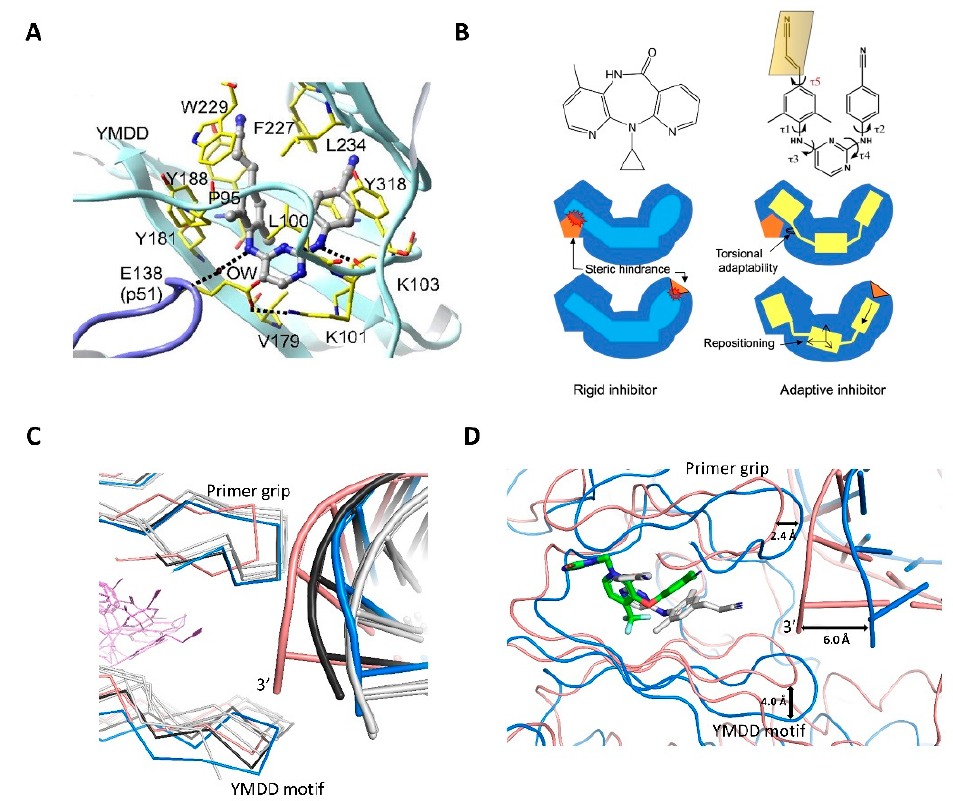
Figure 5. NNRTI binding and its impacts on RT and nucleic acid substrates. ( A ) Binding of RPV (gray stick) to the NNRTI-binding pocket (NNIBP) (PDB ID = 2ZD1); key residues in NNIBP are highlighted in yellow; the figure is reprinted from Reference [103]; copyright (2008) National Academy of Sciences. ( B ) Schematic comparison of a rigid (left) and a flexible inhibitor (right) highlighting the advantage of strategic flexibility to overcome the impact of resistance by adapting to the pocket changes [104]; τ represents rotatable bonds. ( C ) Overlay of wild-type RT/DNA/DOR (salmon; PDB ID = 7Z2G), RT/DNA/RPV (blue; PDB ID = 7Z2D), RT/DNA/NVP (black; PDB ID = 7Z24), RT/dsRNA (PDB ID = 7KJV), RT/dsRNA/NVP (PDB ID = 7KJX), and RT/dsRNA/EFV (PDB ID = 7KJW); all RT/dsRNA structures are in gray. The comparison shows that NNRTIs trap RT in a common conformational state, except for DOR and RPV complexes; the primer grip and the nucleic acid track in the DOR complex, and the YMDD motif in the RPV complex deviate the most. ( D ) C α -superimposition of RT/DNA/DOR (salmon) and RT/DNA/RPV (blue) structures. The inhibitors (DOR in green; RPV in gray) occupy the same pocket space; however, significant shifts in primer 3 (cid:48) -end, conserved YMDD loop, and the primer grip are observed between two structures